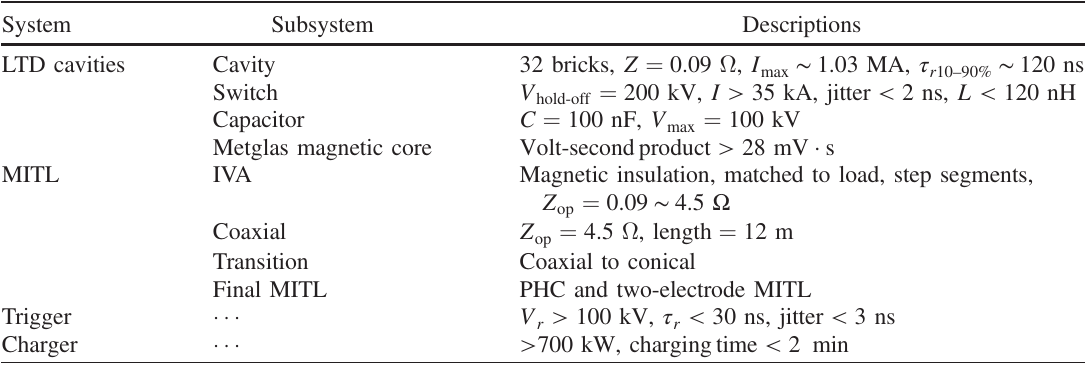
TABLE I. Major specifications of the concept